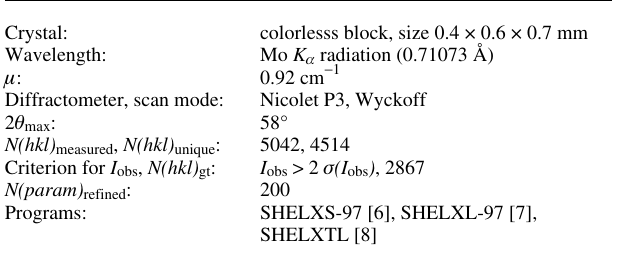
Table 1. Data collection and handling.